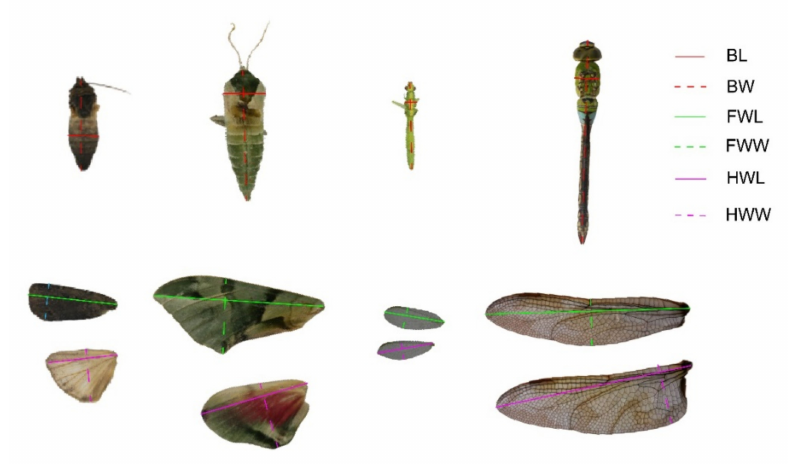
Figure 1. Schematic diagram of morphological variables related to length and width measured for insects. From left to right, each picture represented a lepidopterous insect, a lepidopterous insect, a neuropteran, and a dragonfly. BL indicates body length, BW indicates body width, FWL indicates length of forewing length, FWW indicates forewing width, HWL indicates hindwing length, and HWW represents hindwing